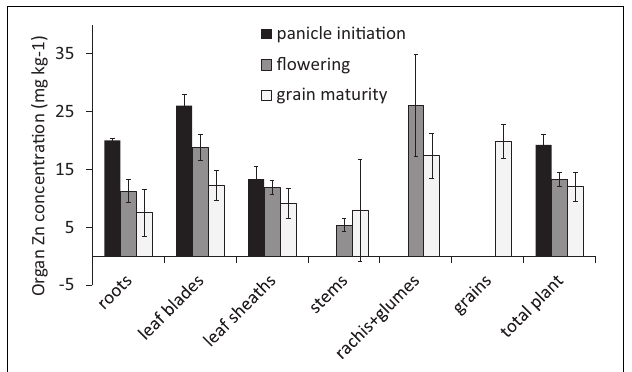
FIGURE 1 | Zinc concentrations (mg kg − 1 ) in the different organs at three harvests averaged across the different 70 Zn application treatments (Experiment 1). Error bars indicate standard errors where n = 2, 4, and 6 at panicle initiation, flowering, and grain maturity,